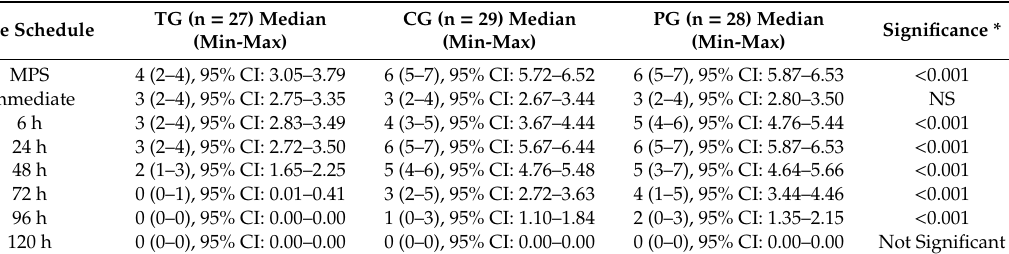
Table 2. The maximum pain score and pain experienced at each schedule, assessed via the Numeric Rating Scale (NRS). TG = Tested group, CG = Control Group, PG = Placebo Group. MPS = Maximum Pain Score. * p -value set as ≤ 0.05. Assessed by Kruskal–Wallis H Test .